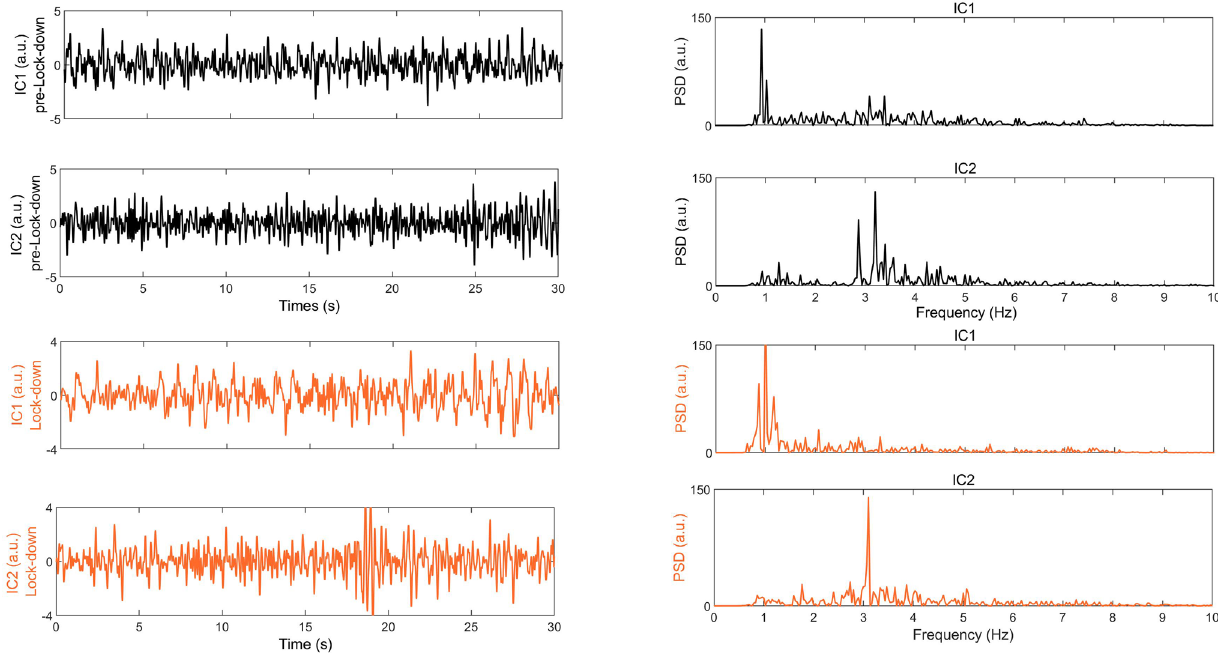
Figure 5. An example of ICA extraction: comparison between the decomposed signals (IC1 and IC2) in pre-lockdown (in black) and lockdown (in orange). As it can be seen, IC1 is always well peaked and extracted, whereas IC2 is much well extracted during the lockdown (a sharped frequency content vs a multiple-peak band). The original series in this example are relative to Jan 13, 2020, 15:32 UTC (in pre-lockdown) and Apr 09, 2020,15:32 UTC (in lockdown) considering all the